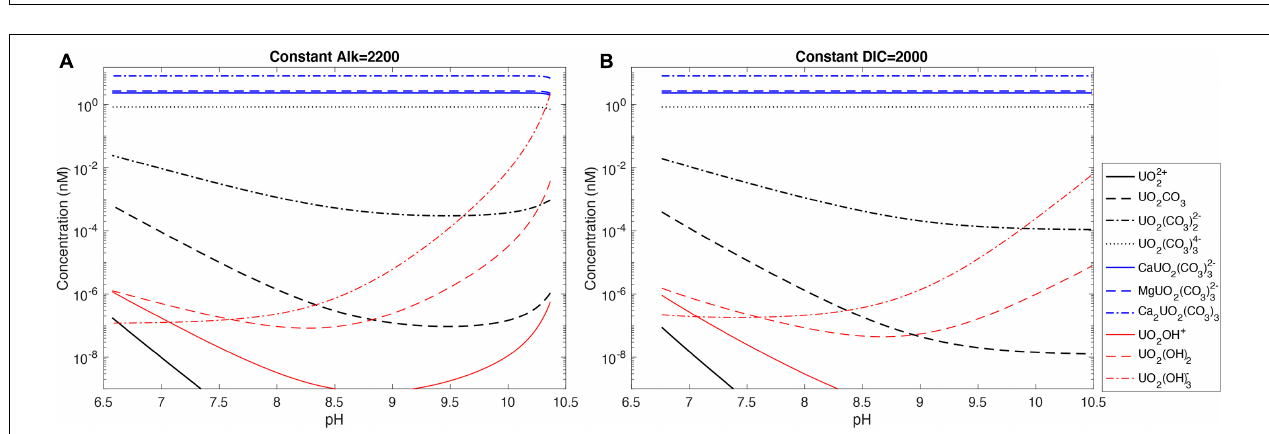
FIGURE 5 | Uranium speciation in seawater with pH at (A) constant alkalinity of 2,200 µ eq/kg and (B) constant DIC of 2,000 µ mol/kg. A total uranium concentration of 13.8 nmol/kg is used for the